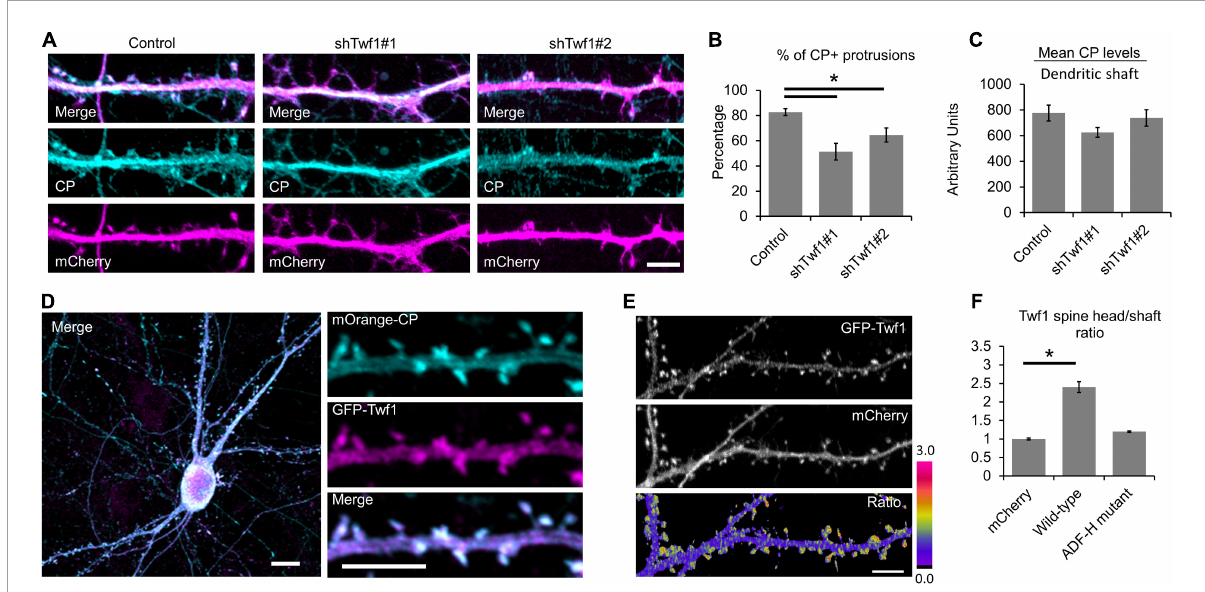
FIGURE5 Twinfilin-1 (Twf1) is enriched in spines. (A) Knockdown of Twf1 reduces capping protein (CP) enrichment in dendritic protrusions. Representative images of DIV21 hippocampal control, shTwf1#1, and shTwf1#2 neurons co-expressing mCherry (magenta), fixed and immunostained for endogenous CP (cyan). Scale bar, 5 µ m. (B) Analysis shows the percentage of dendritic protrusions that contain CP. N = 19 neurons. (C) Analysis of mean CP fluorescence intensity relative to control. N = 19 neurons. (D) Representative image of DIV21 hippocampal neuron co-expressing mOrange-CP (cyan) and GFP-Twf1 (magenta). Inset shows magnified view of CP and Twf1 localization in spines. Scale bars: main image = 10 µ m, inset = 5 µ m. (E) Representative images of GFP-Twf1, mCherry, and their ratiometric pseudocolor presentation highlighting the Twf1 spine enrichment. Scare bar = 5 µ m. (F) Quantification of spine head enrichment relative to the neighboring dendritic shaft for wild-type Twf1 and the actin depolymerization factor homology (ADF-H) domain mutant of Twf1 compared to soluble mCherry. N = 16 neurons (12 protrusions/cell) per condition. Error bars represent SEM. * P < 0.05; one-way ANOVA with Tukey’s post hoc test.